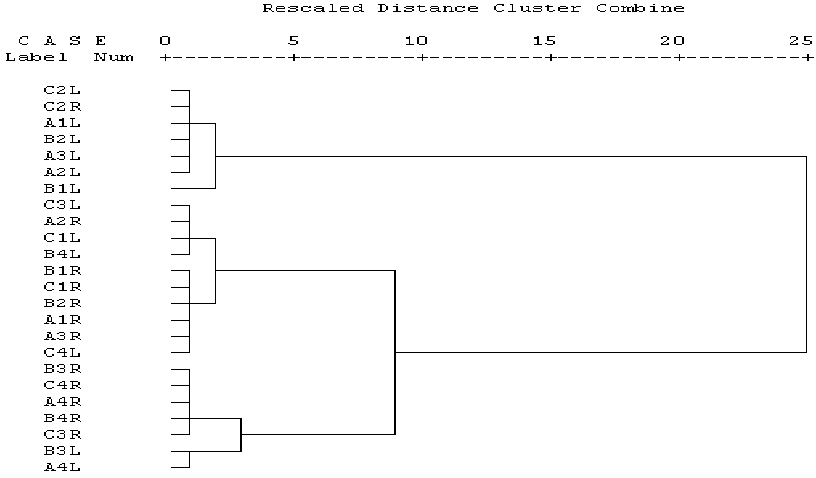
Figure 2. Dandrogram of major compounds (phenyl propanoids) in ACLEO and ACREO prepared Software SPSS, ward method with square Euclidean distance measure. Where 1 = spring, 2 = summer, 3 = autumn, 4 = winter seasons, L = A. calamus leaves essential oils (ALEO), R = A. calamus rhizomes essential oils (RLEO). Table 3. Classes of compounds identified in ACLEO from four seasons.